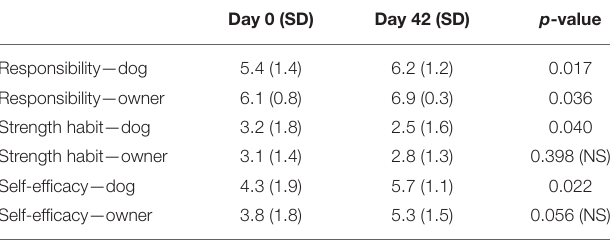
TABLE 5 | The mean of perceived responsibility, strength of habit, and self-efficacy of (all participants combined), dog-centered